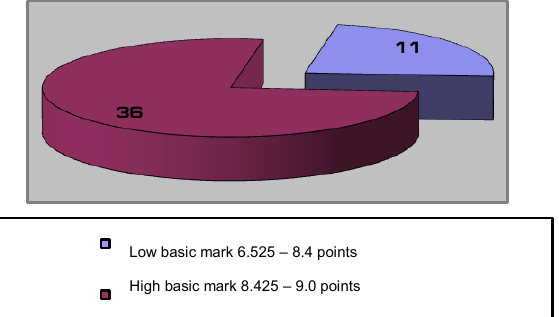
Fig.2. Determination of performance mastering of female gymnasts (mark for